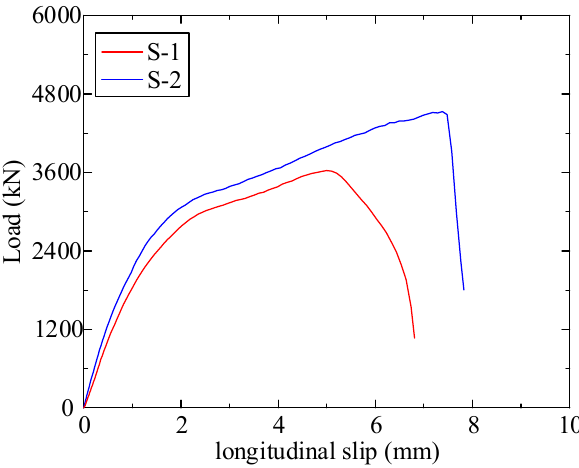
Figure 12. Load–longitudinal slip curves of S-1 and S-2. Table 3. Result comparison of push-out test specimens.